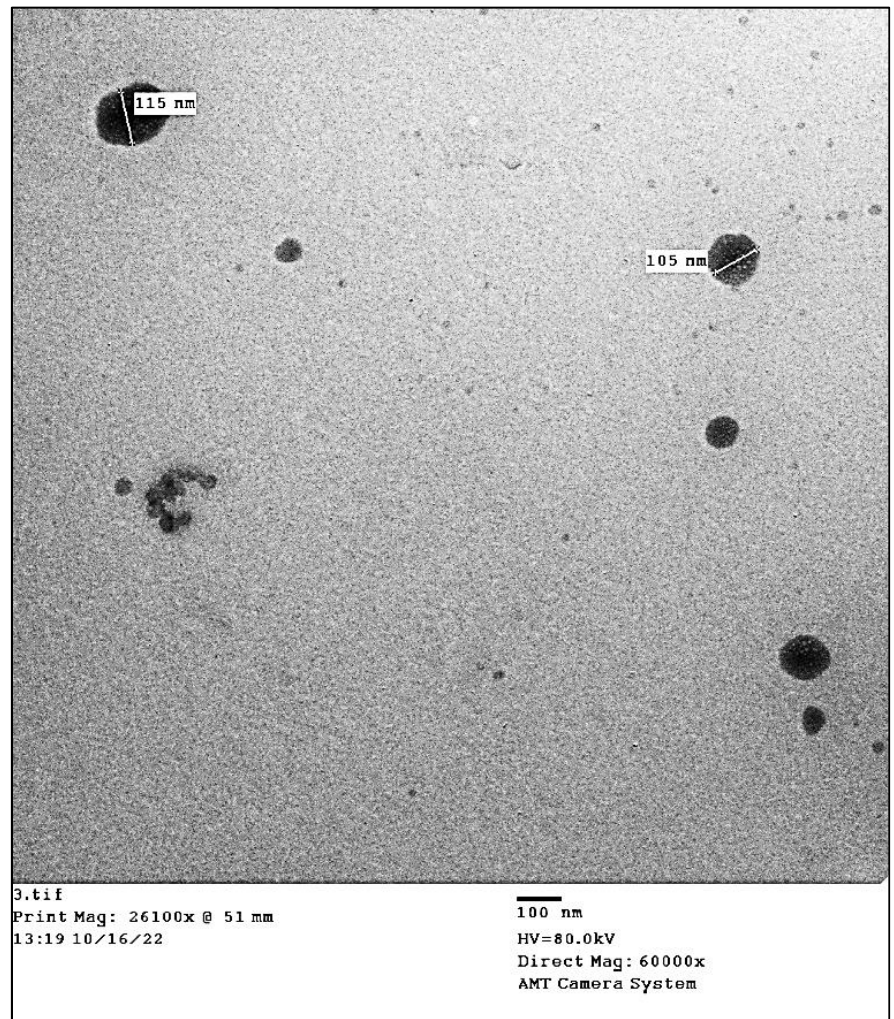
Figure 3. TEM image for SiO 2 -NPs showing spherical